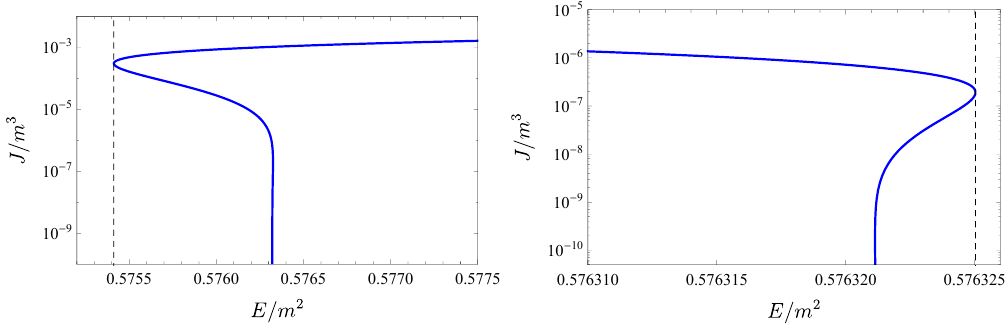
Figure 4 . The E – J curve for T = 0 . The vertical axis is shown in a log scale. The right panel shows the zooming in of the left panel around the critical value of the electric field. The vertical dashed lines in the left panel and the right panel denote the electric field at the first and second turning point values, respectively: ( E (1) /m 2 , J (1) /m 3 ) = (0 . 575412 , 3 . 0031 × 10 − 4 ) and turn turn ( E (2) /m 2 , J (2) /m 3 ) = (0 . 5763250 , 1 . 9178 × 10 − 7 ) turn turn